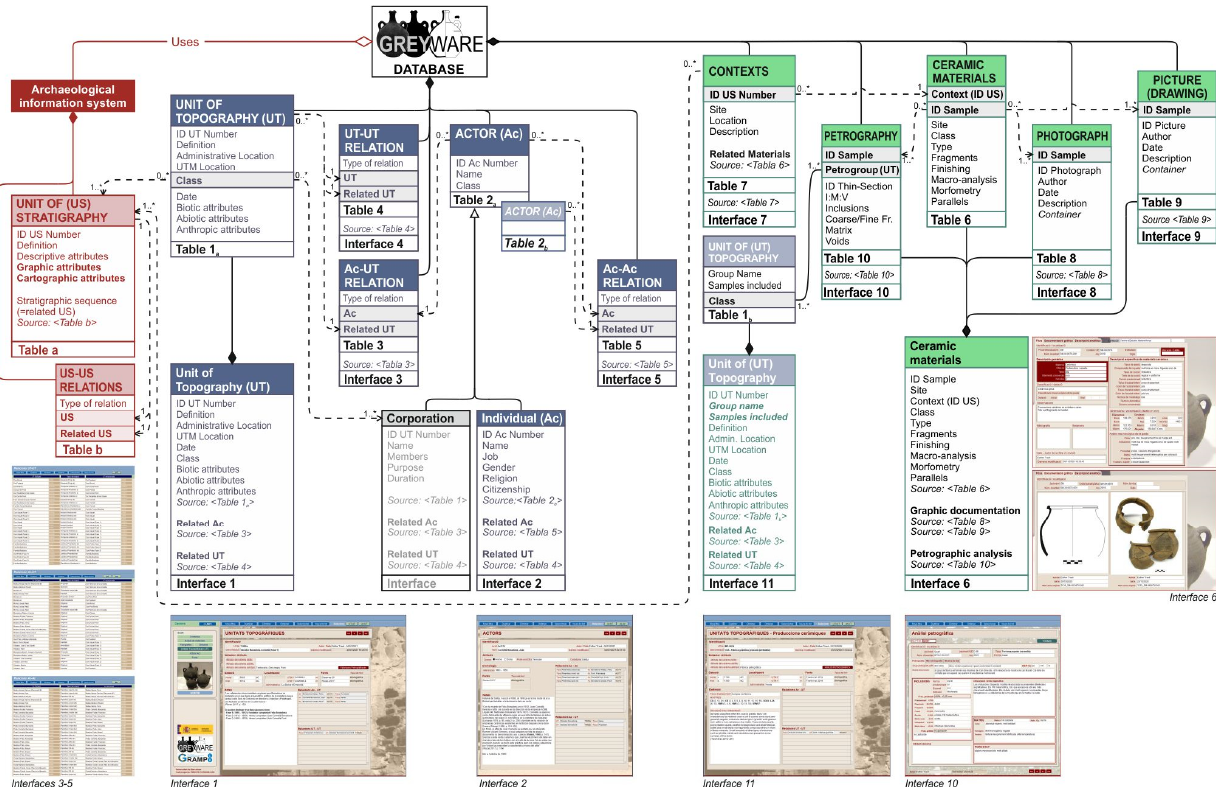
Figure 6. UML diagram of the G REYWARE database table-structure and components. The system commits a domain (pottery analysis) ontology and a top-level (H ORAI UT/Ac) ontology whose categories are represented in green and blue shading, respectively.